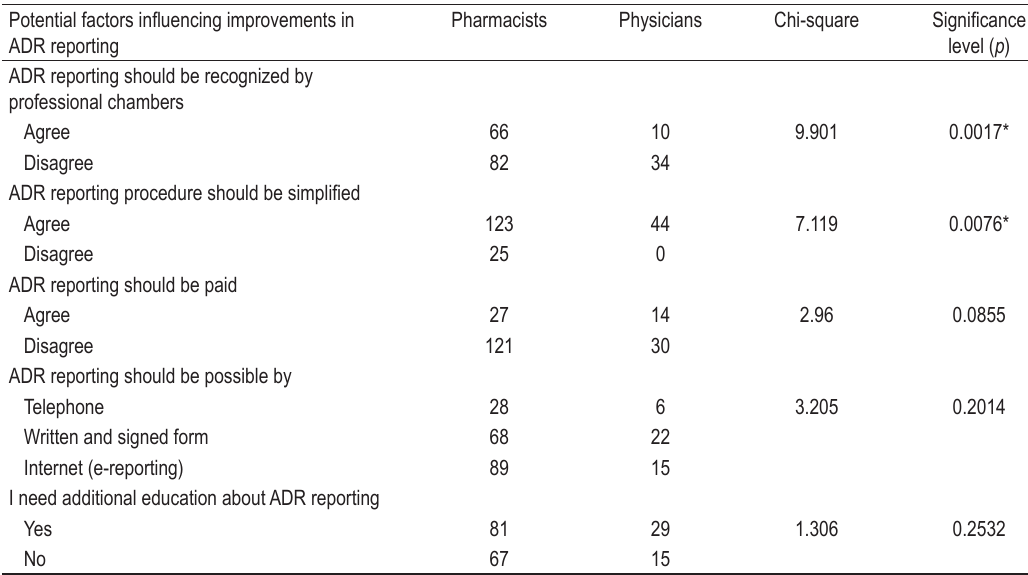
TABLE 4. Potential factors influencing improvements in ADR reporting Potential factors influencing improvements in ADR